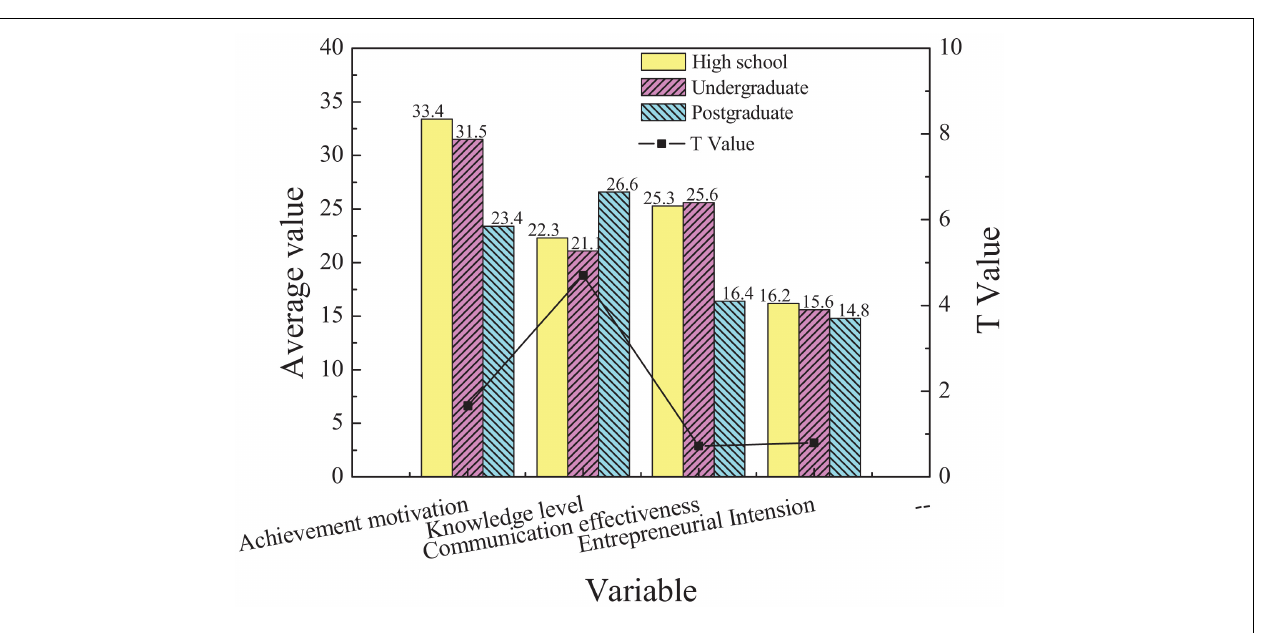
FIGURE 4 | Comparison of scores of entrepreneurs with different level of education in different EI